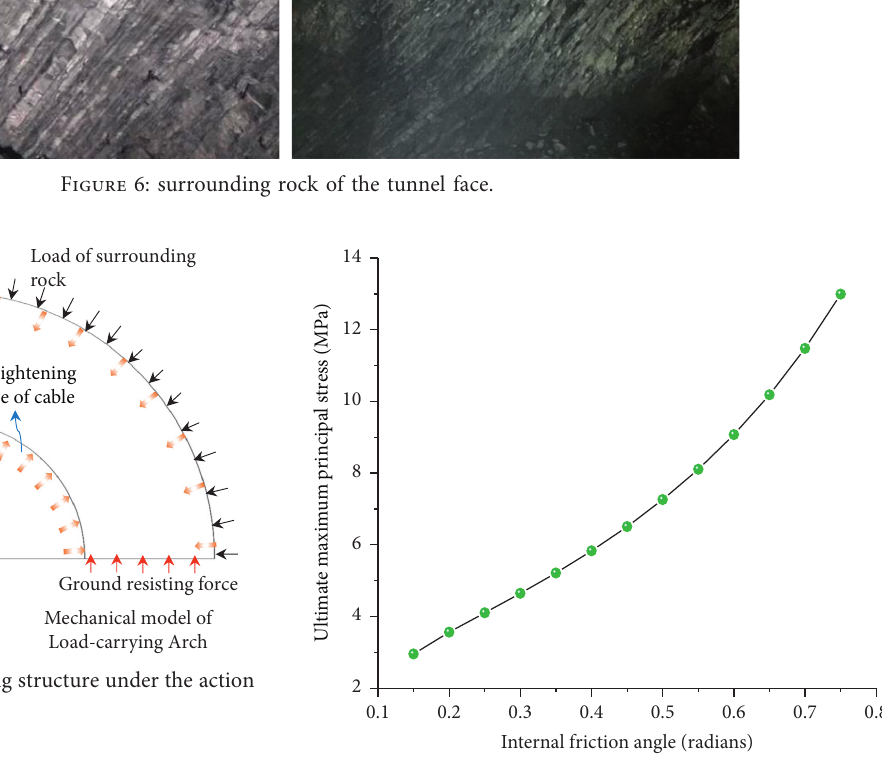
Figure 9: The change of the maximum bearing capacity with the internal friction angle.